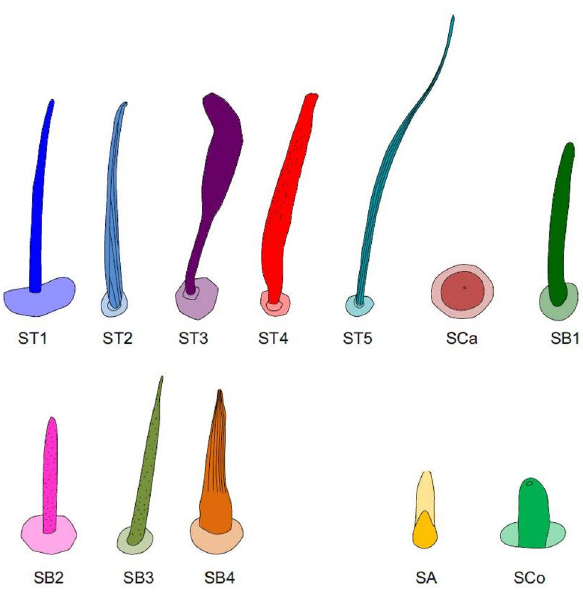
Figure 9. The schematics of antennal sensilla of Naucoridae. ST sensilla trichodea, SCa sensilla campaniformia, SB sensilla basiconica, SA sensilla ampullacea, SCo sensilla